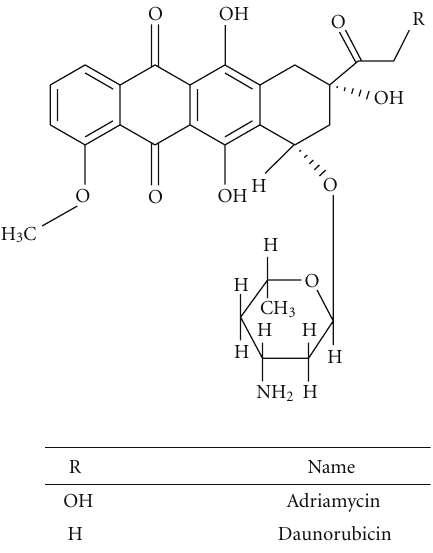
Scheme 2: Two-electron reduction of quinone in aqueous bu ff er.